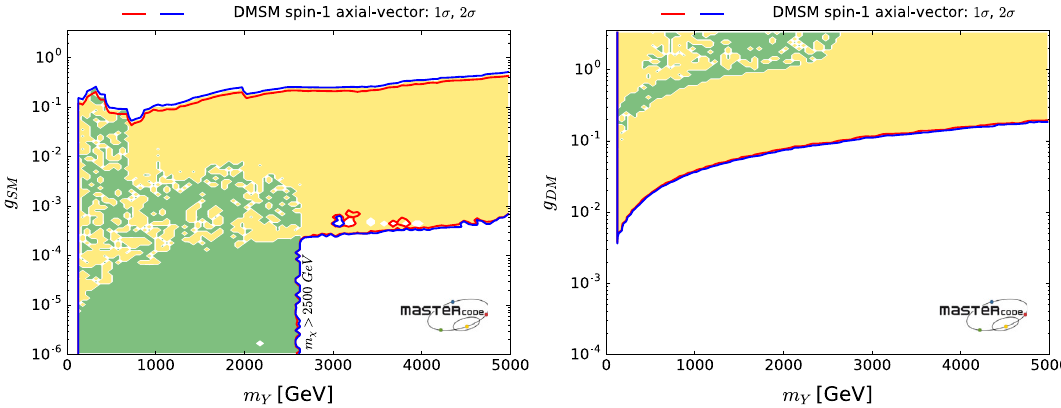
Fig. 11 The likelihood functions for g SM (left panel) and g DM (right panel) as functions of m Y in the model with axial-vector couplings. We again use colour coding to illustrate the dominant mechanisms bring- ing the DM density into the allowed range: green for annihilation via t -